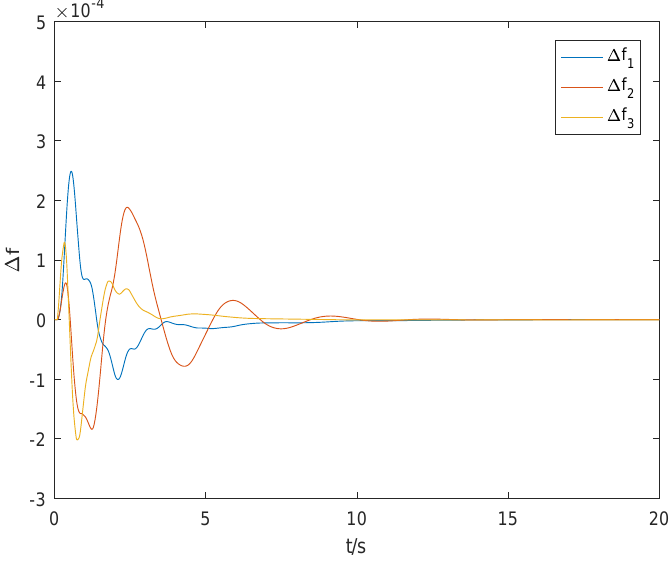
Figure 3. Frequency deviation of three areas with secure control